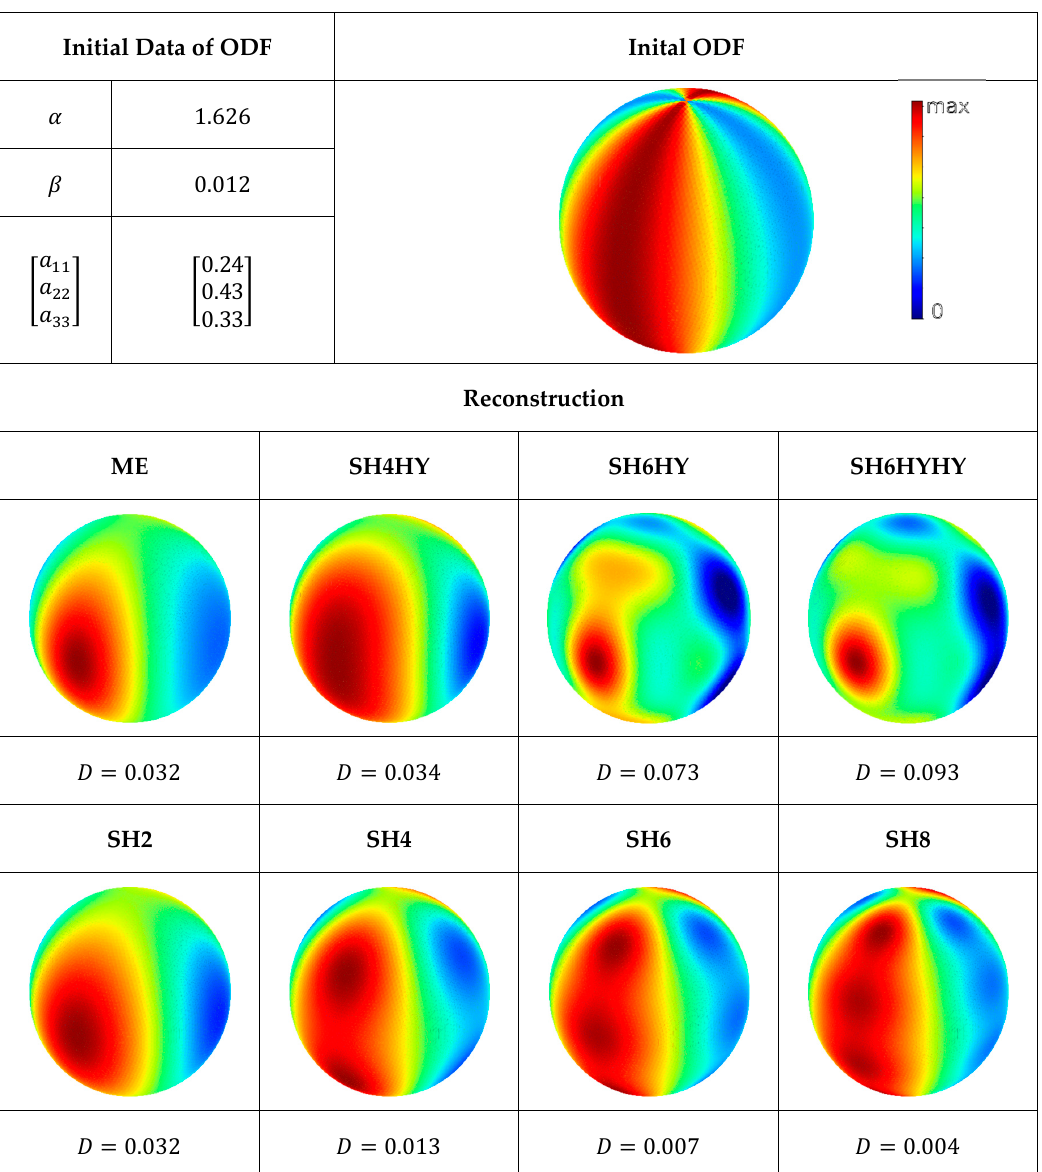
Figure 7. Top: Initial ODF and data of fourth test case. Bottom: Reconstruction of test case with the different reconstruction methods.